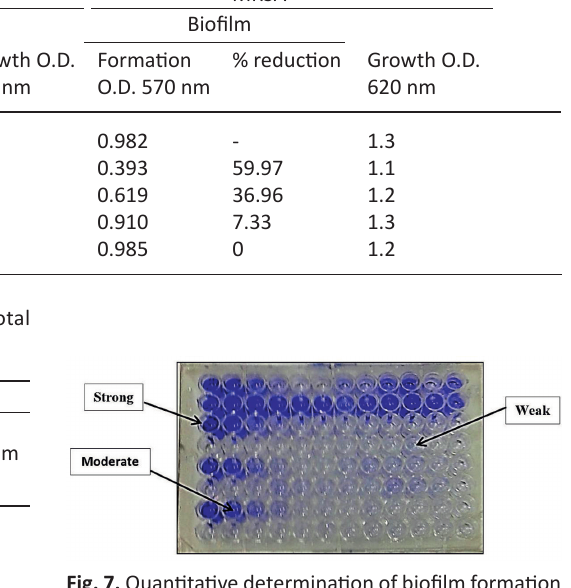
Table 6. Anti-biofilm effect of polyphenol fraction of Z. spina-christi on S. aureus and MRSA biofilm S. aureu s Sub-MICs